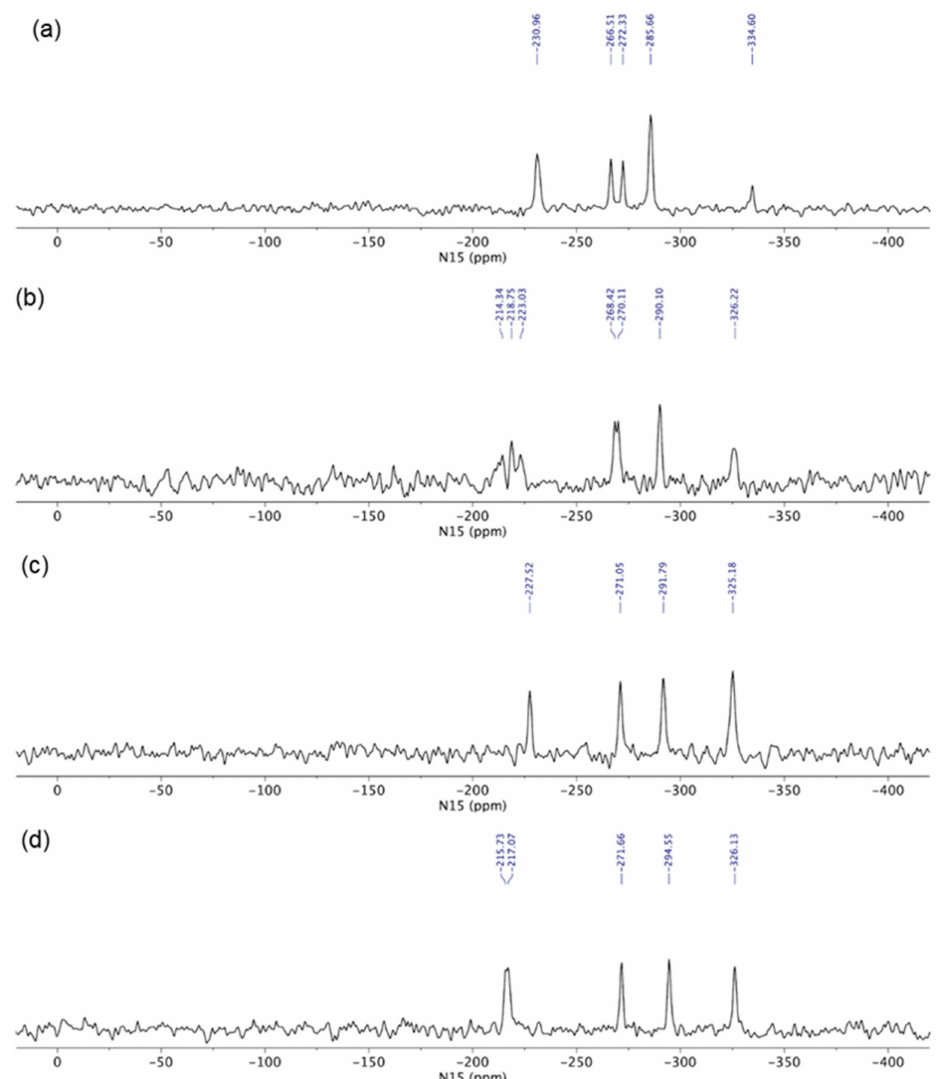
Figure 8. 15 N CP MAS ssNMR ( 15 N cross-polarization magic-angle spinning solid-state nuclear magnetic resonance) spectra of ( a ) glasdegib base, ( b ) glasdegib dihydrochloride, ( c ) glasdegib monomaleate and ( d ) glasdegib